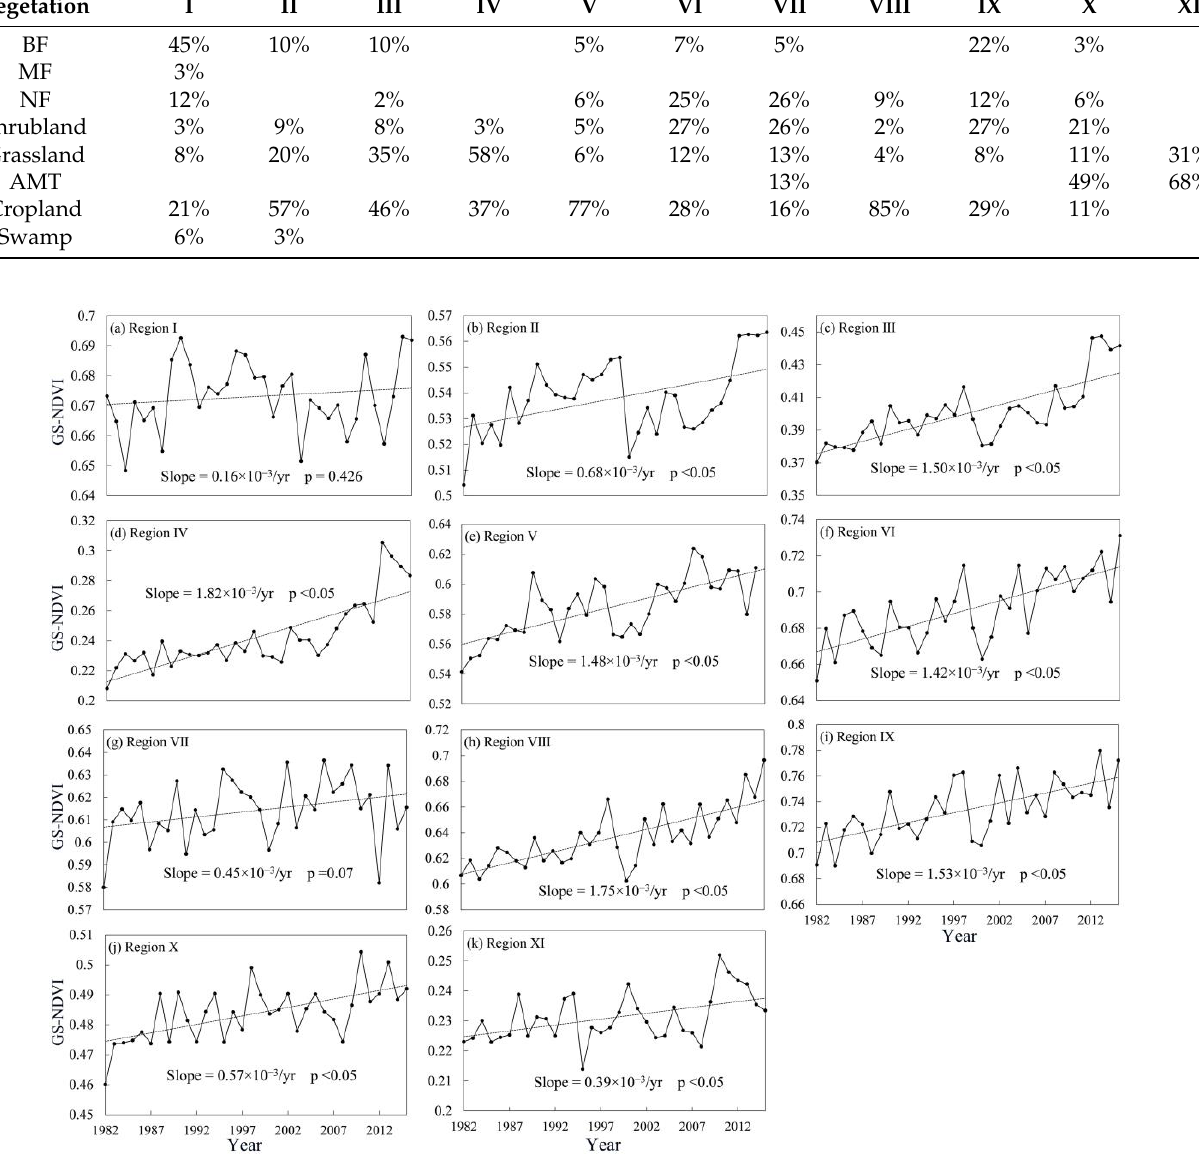
Figure 5. Inter-annual variation in the GS-NDVI in 11 sub-regions during 1982 – 2015.